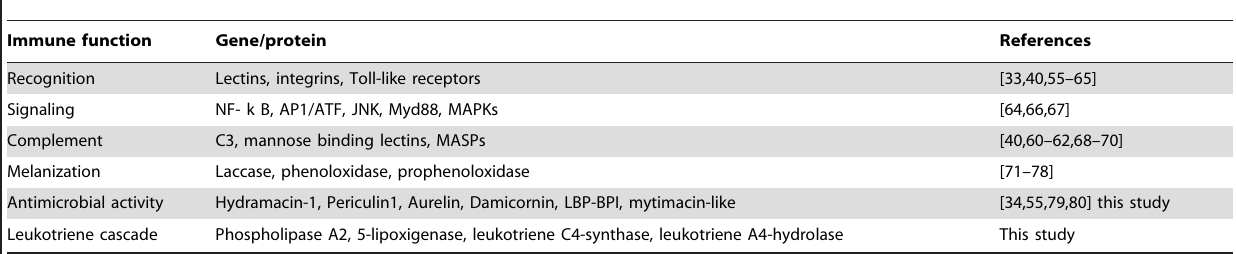
Table 5. Summary of the cnidarian immune genes